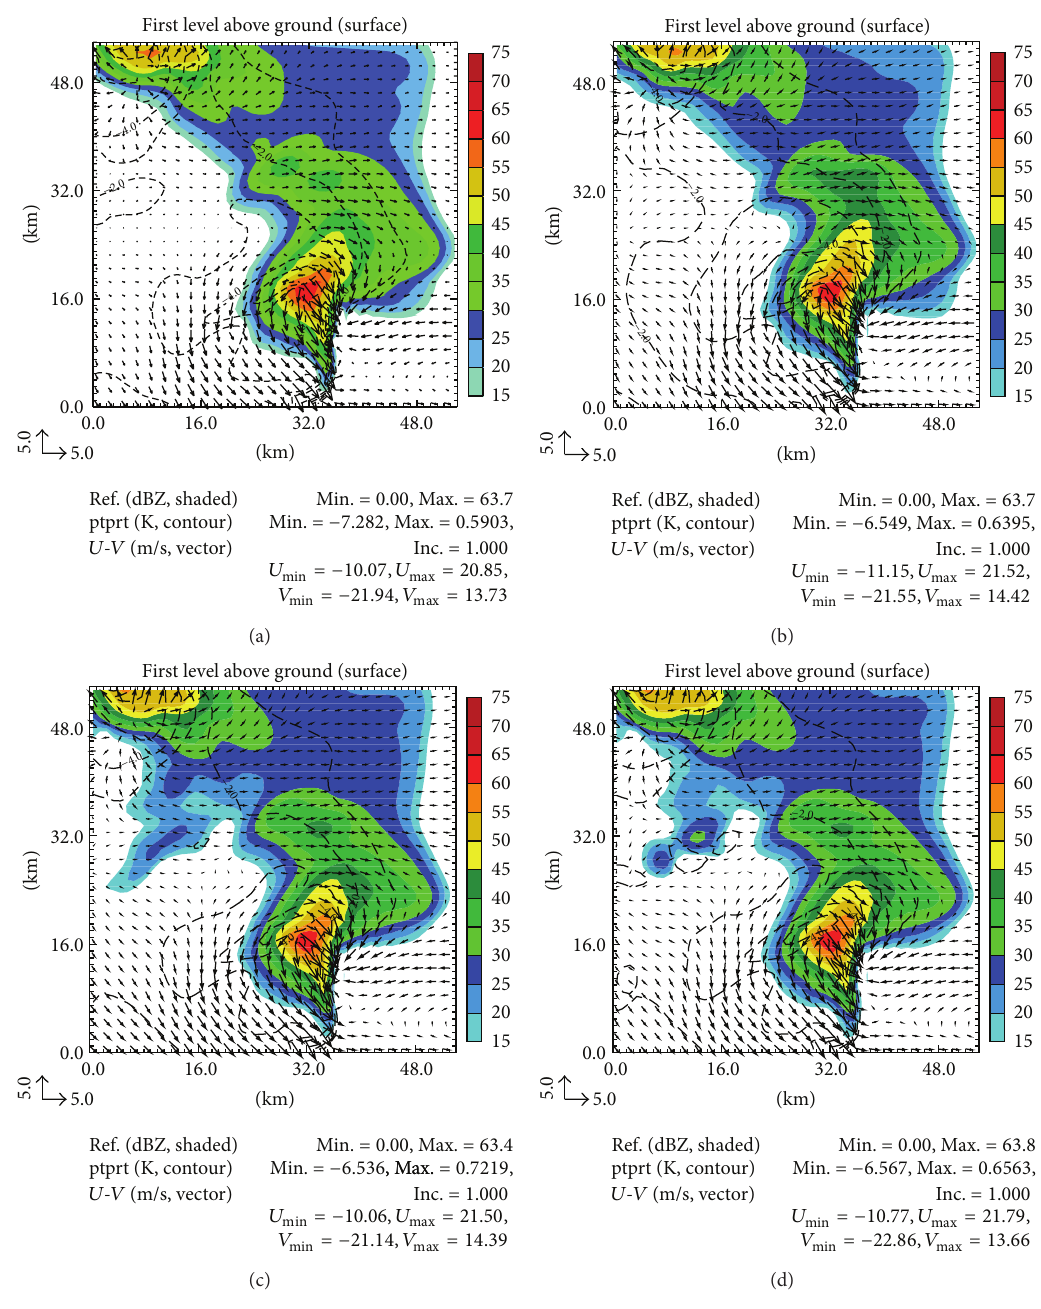
Figure 5: The same as Figure 3 but for the experiment with two